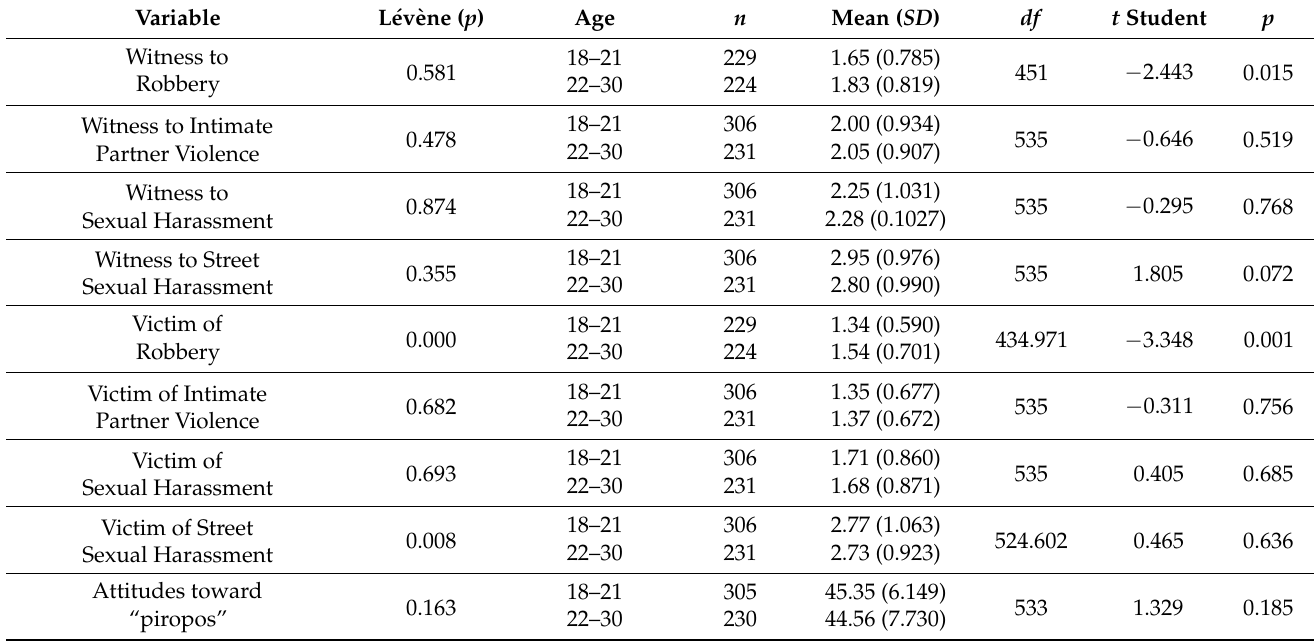
Table 6. Victimization and attitudes toward “piropos” by